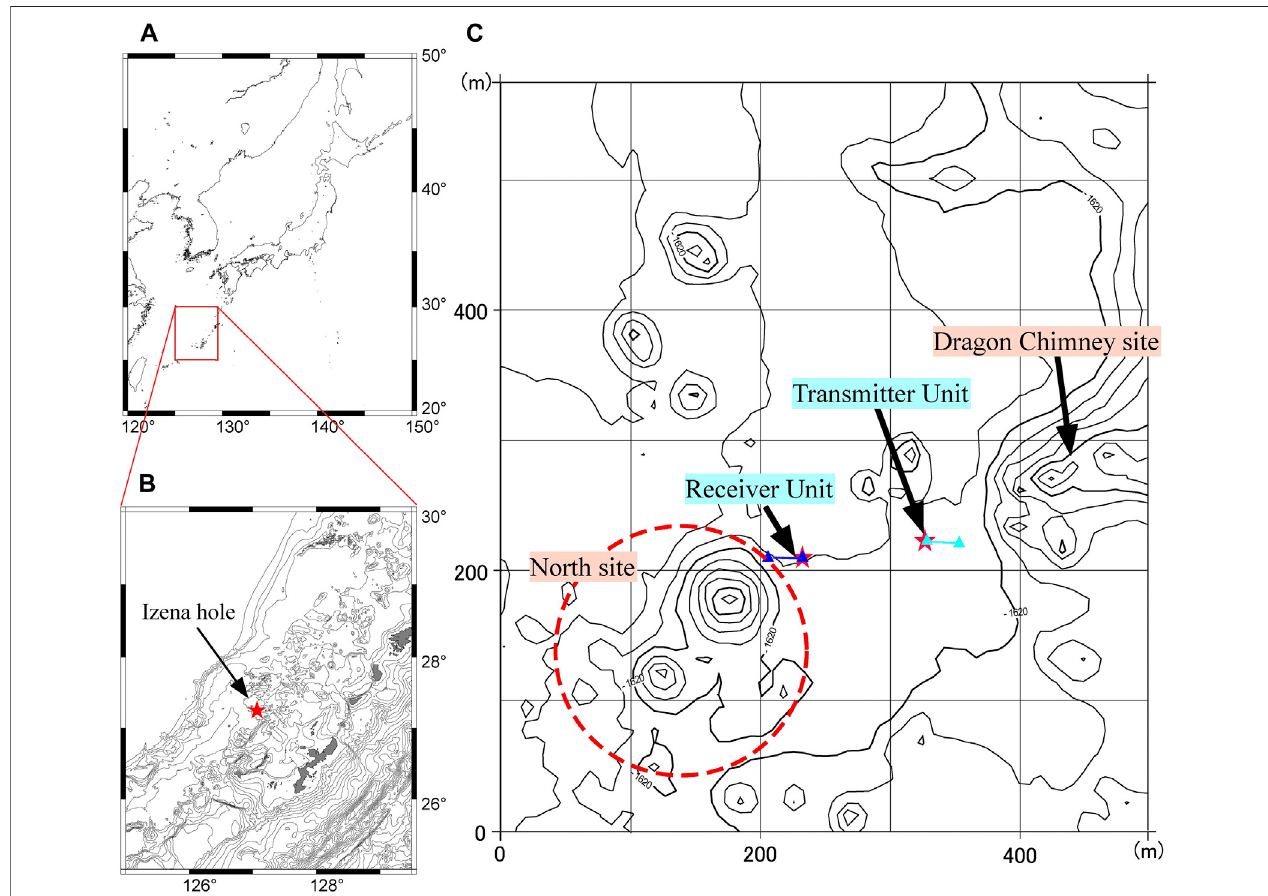
FIGURE 2 | Maps of the survey area: (A) regional map around Japan, (B) map of the mid-Okinawa Trough with the location of the Izena hole, and (C) map of the survey area in the Izena hole. Known hydrothermal mounds are marked. Locations of the receiver and transmitter units are marked by stars, with blue (for receiver) and light blue (for transmitter) triangles indicating the nearest and furthest electrodes of these units. The distance between each unit was 90.5 m, and that between the westernmost source electrode and the easternmost potential electrode (ch. 1) was 97.5 m.